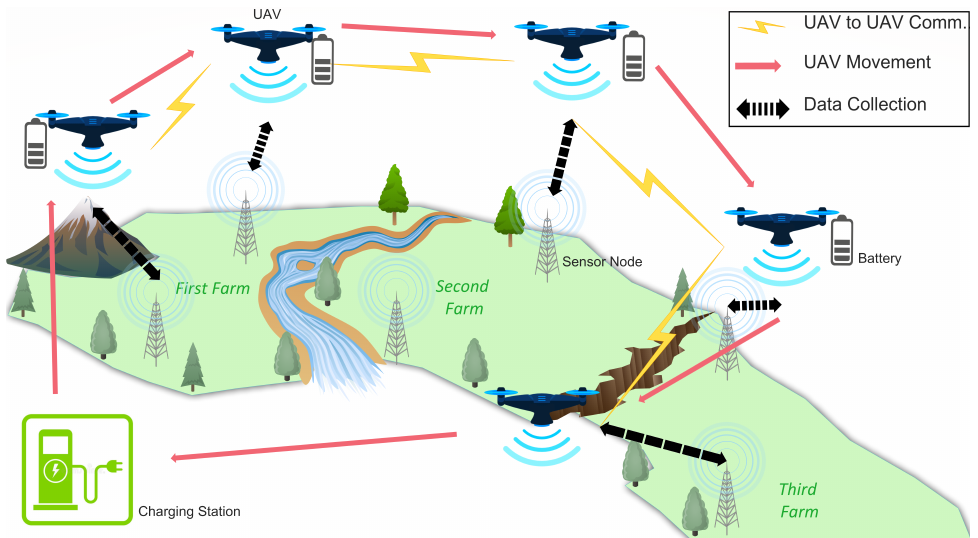
Figure 1. UAV-assisted precision agriculture